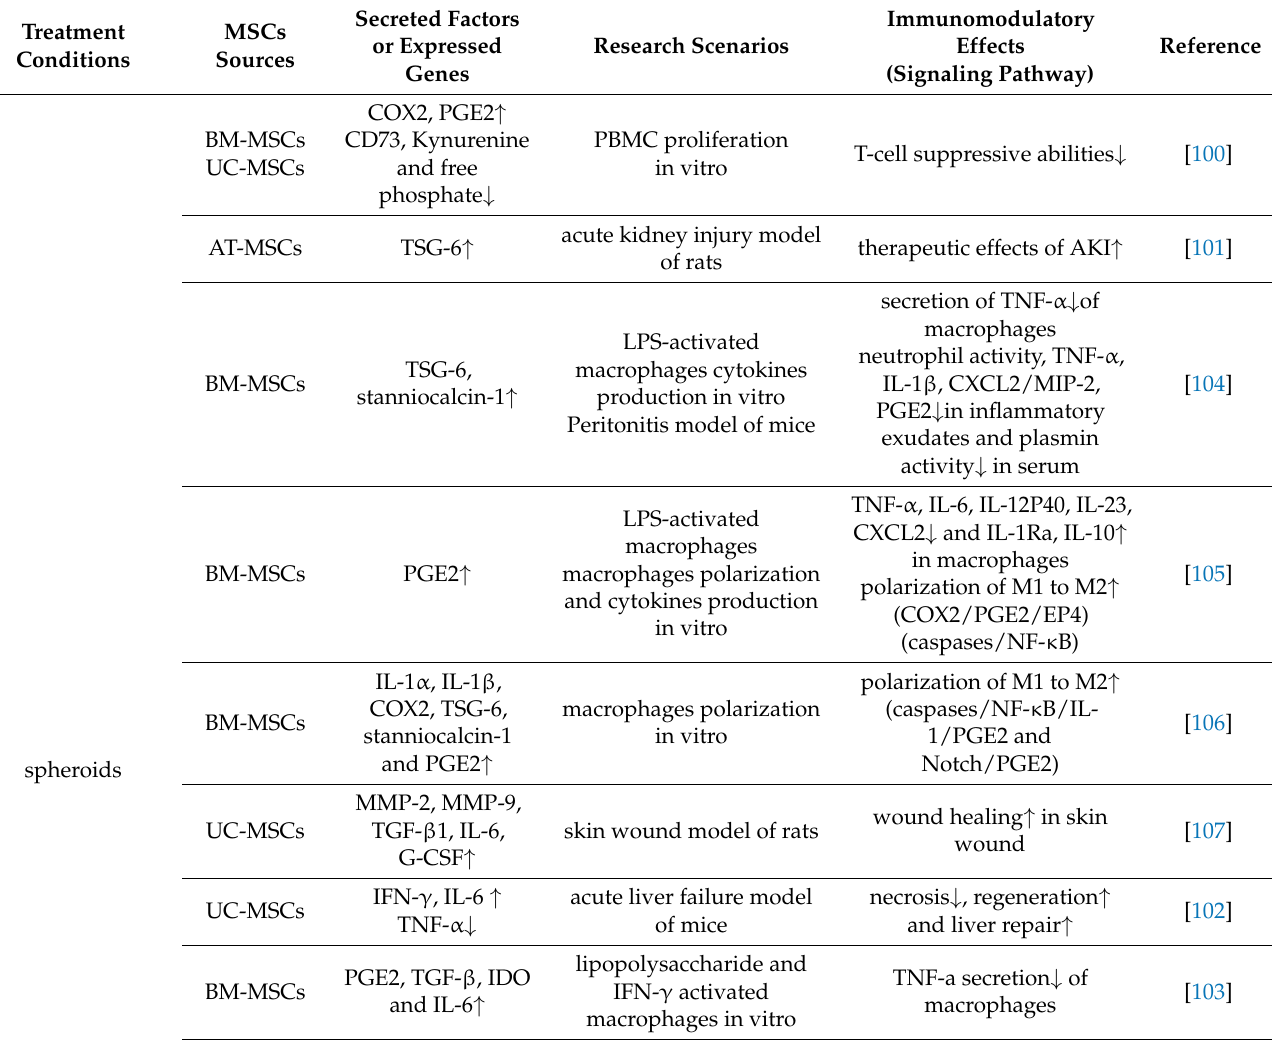
Table 3. 3D culture pretreatment of